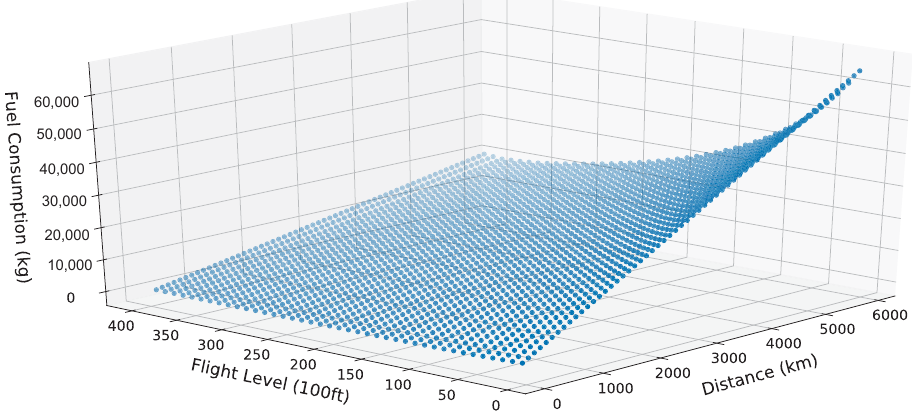
Figure 1. Total fuel consumption of Airbus A320 as a function of distance and flight level